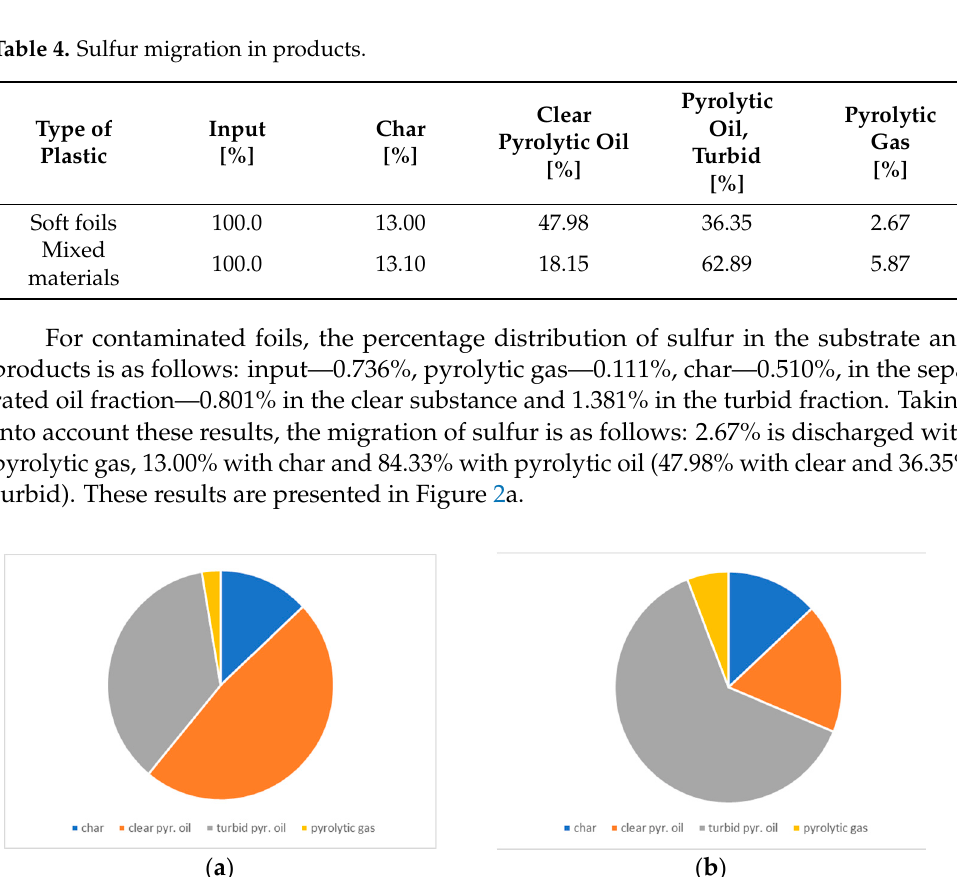
Table 4. Sulfur migration in products.